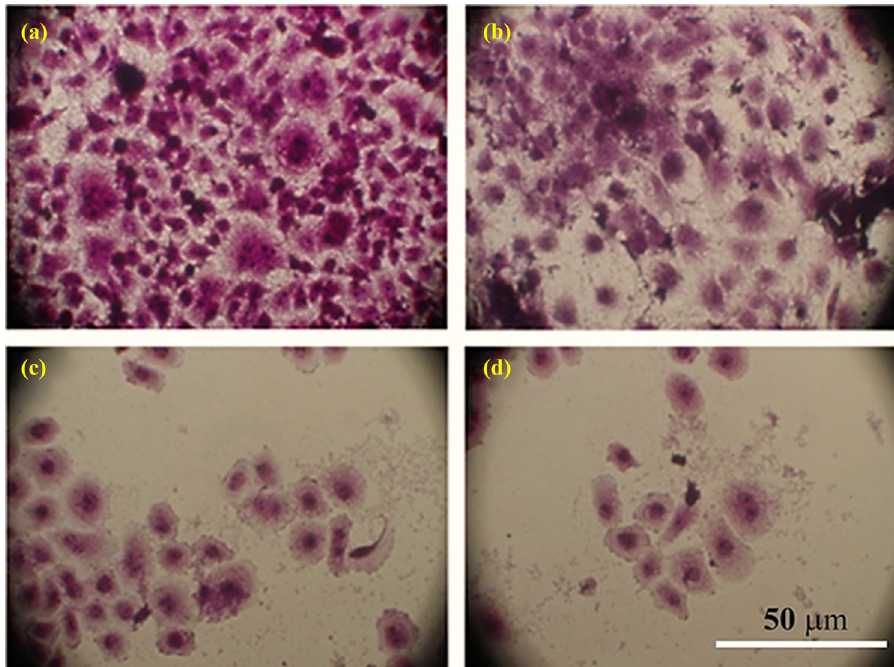
Figure 9: Morphological changes: changes in AMJ13 cell lines stained with crystal violet dye after treatment with CHR, AuNPs, and CHR – AuNPs: ( a ) non - treated control cells, ( b ) CHR - treated cells, ( c ) AuNPs - treated cells, and ( d ) CHR – AuNPs - treated cells.